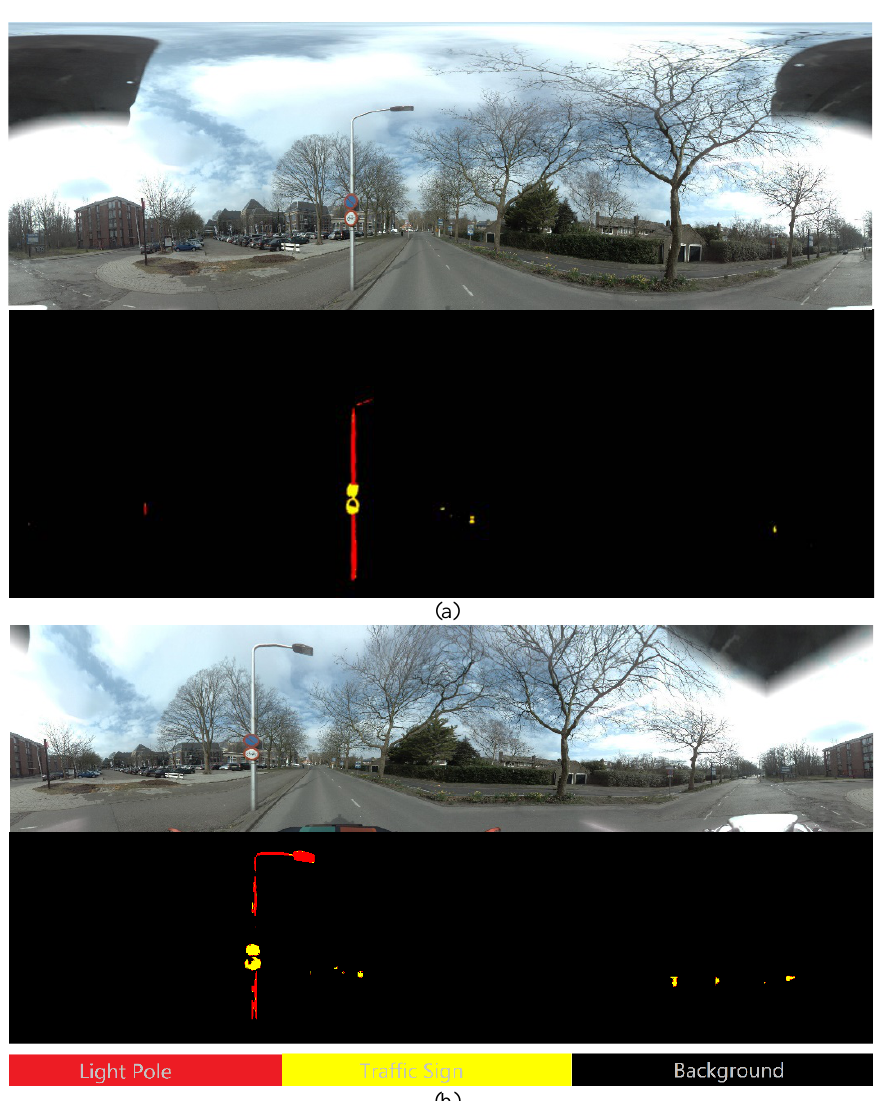
Figure 12. (a) The panoramic image and its protections. (b) The transformed image and its predictions.